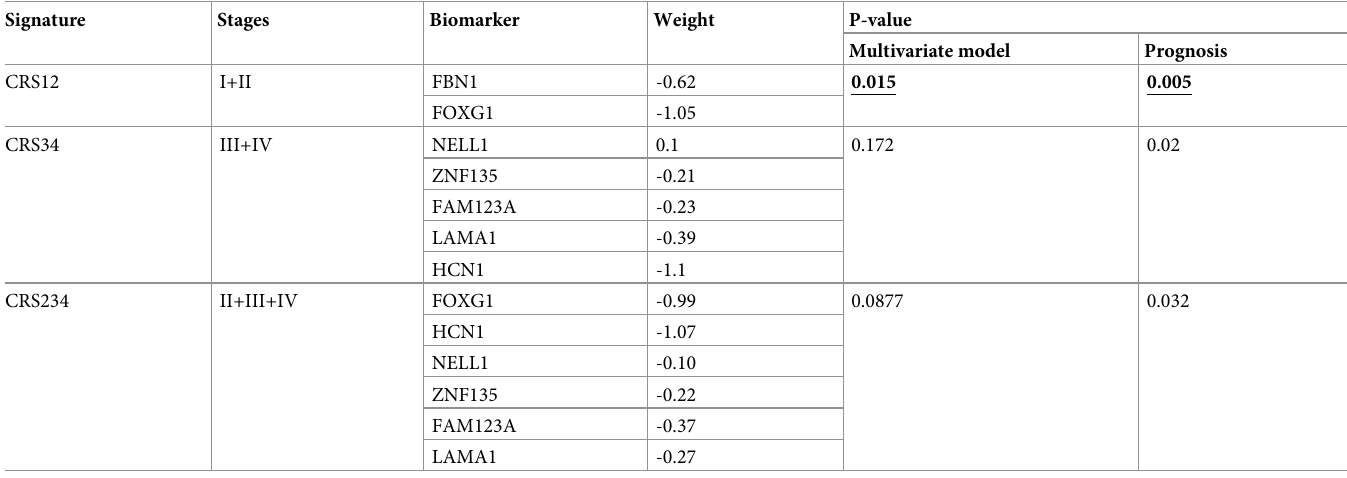
Table 7. Summary of selected multivariate prognostic